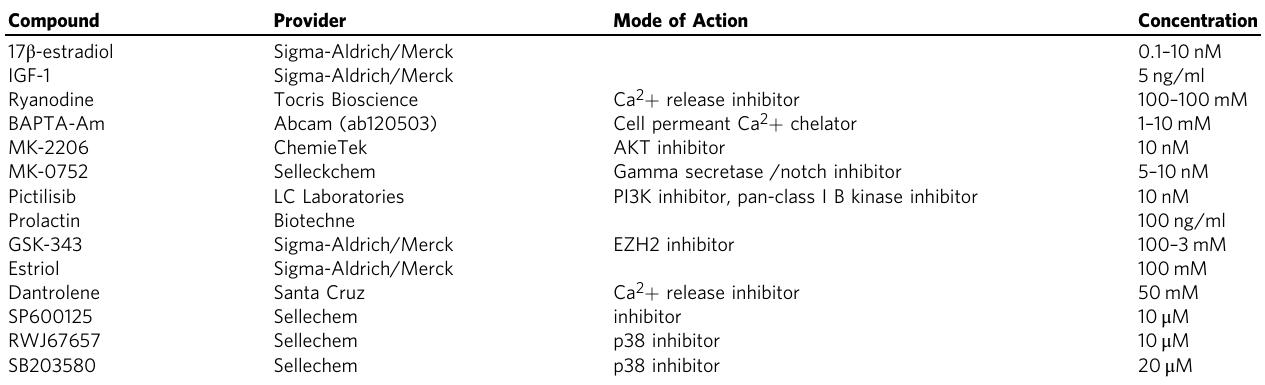
Table 1 The table represents a list of compounds tested in ER α